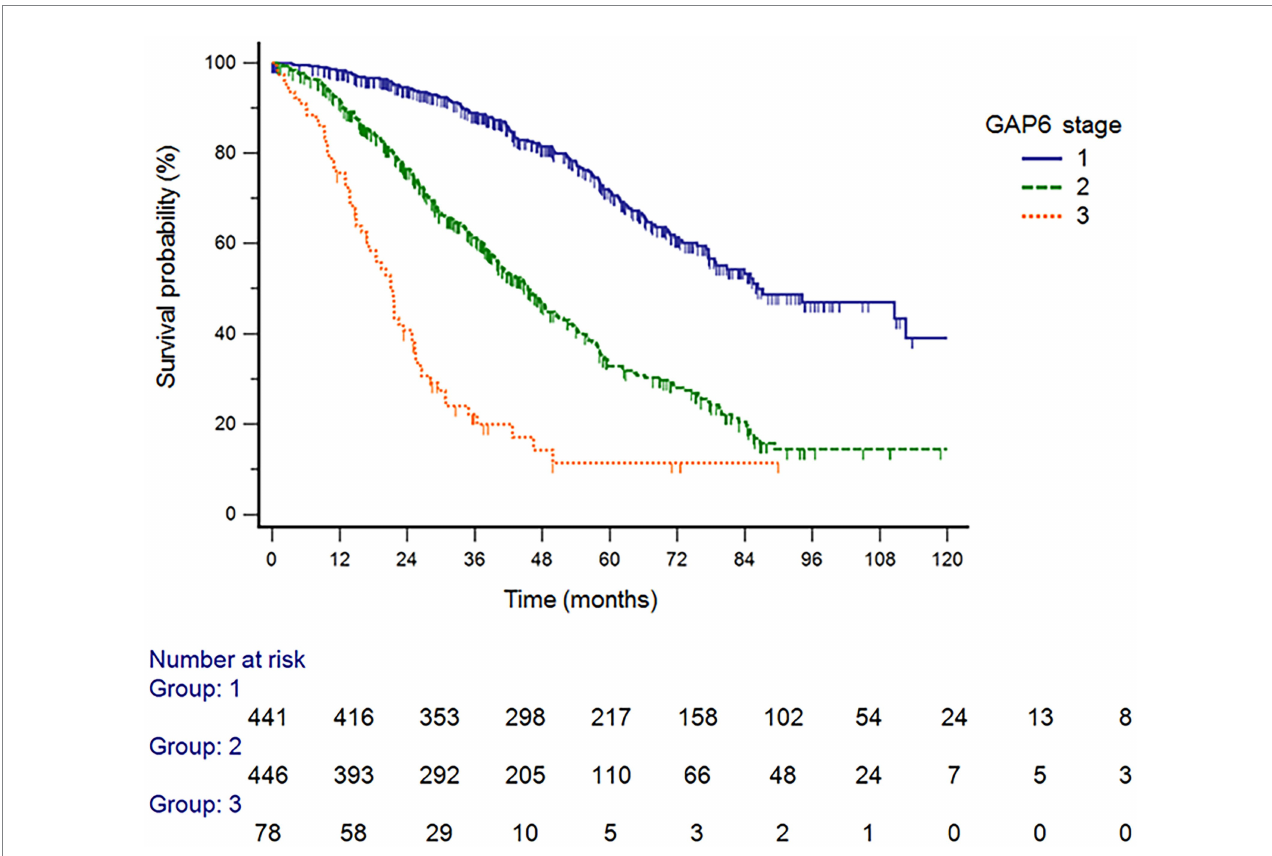
FIGURE 3 Survival probability analysis using Kaplan–Meier plotting, the 3-year mortality rates for the GAP6 stage I, II, and III groups GAP6, gender, age, and physiology with desaturation during six-minute walk test.